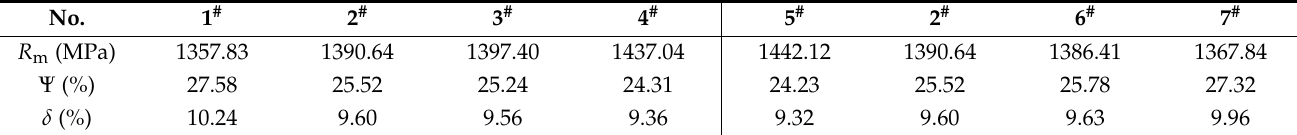
Table 7. Mechanical properties of the experiment